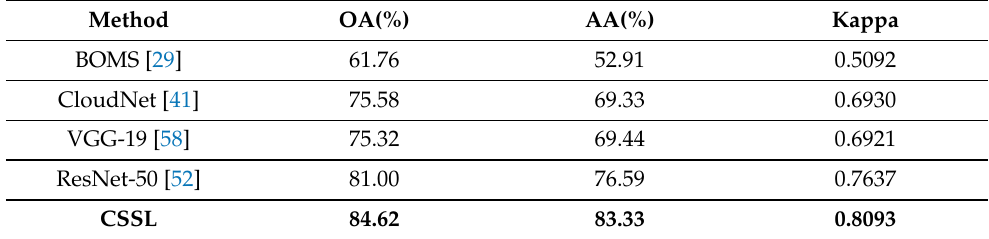
Table 3. Comparisons with other methods.